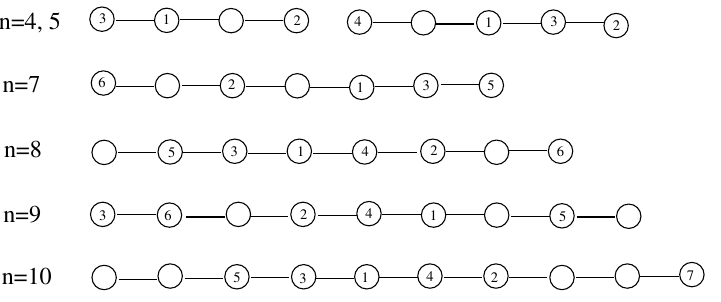
Figure 1: Minimum irregular dominating labelings of P